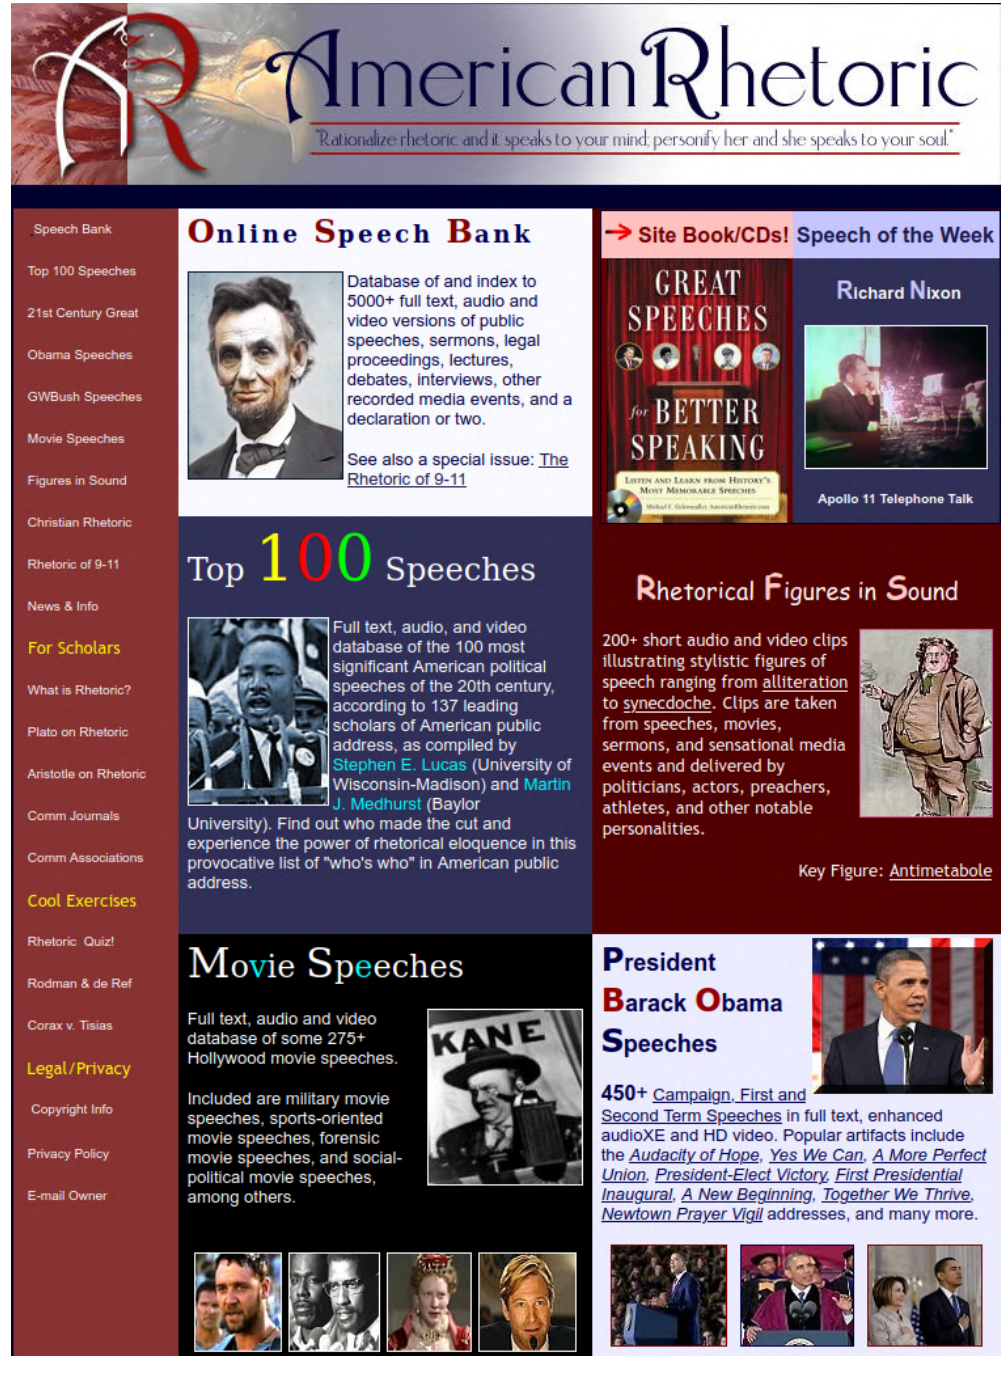
Figure 2: American Rhetoric resource.